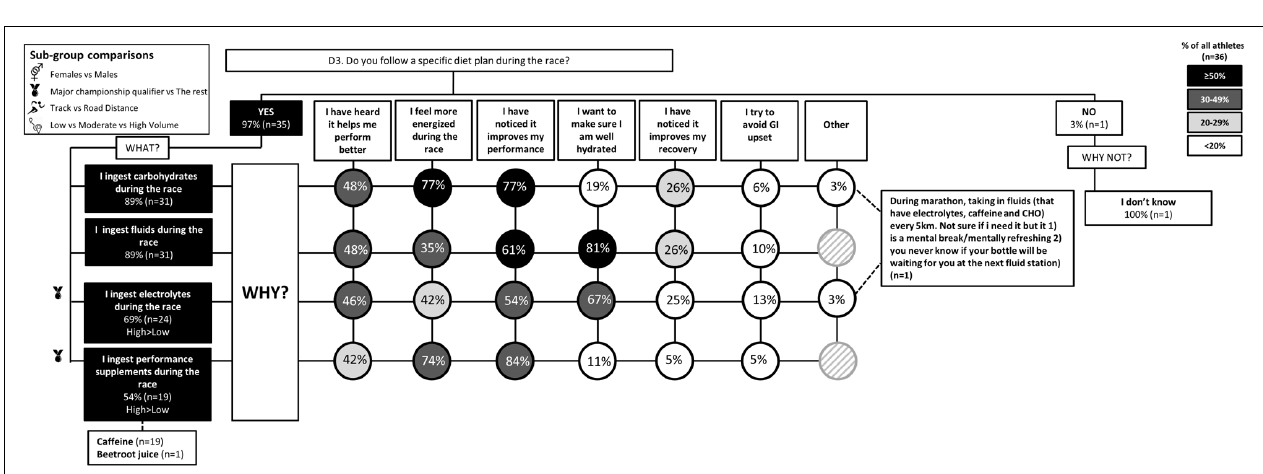
FIGURE 10 | D2: Nutrition on race day. The prevalence of specific nutrition strategies and the reasons for them in 83 elite female and male track and field endurance athletes on the day of the main race. Please see full description for figure within Figure 1 .